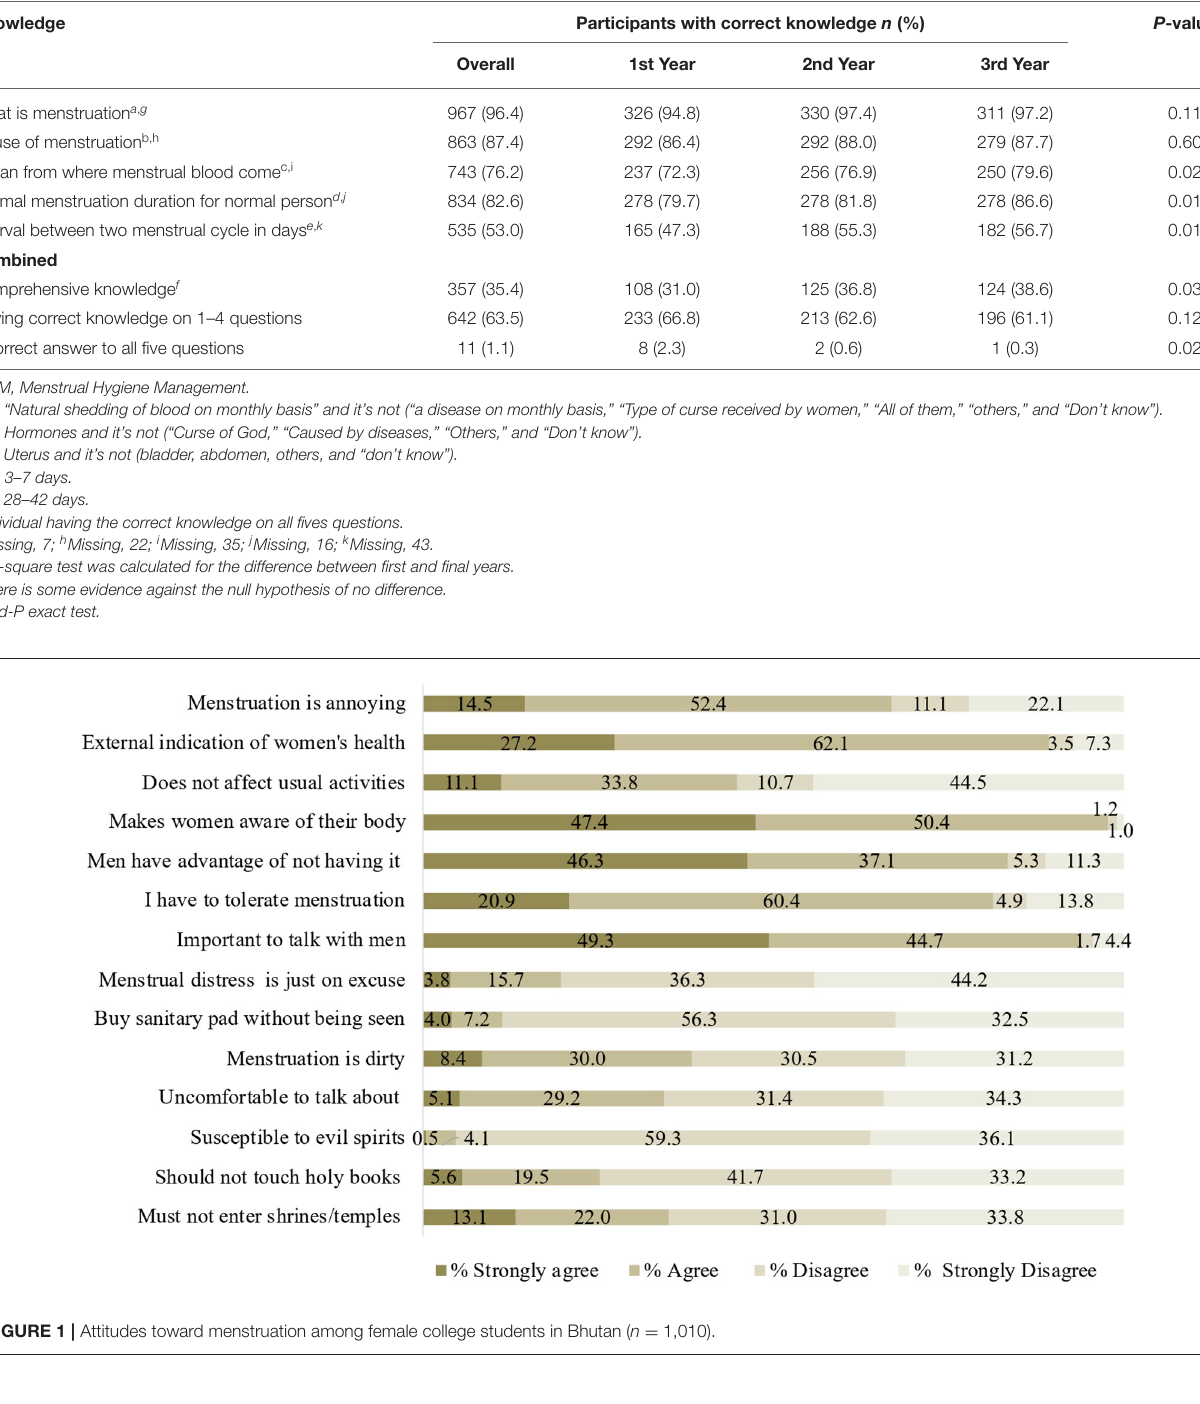
Platform for Discussion and Education